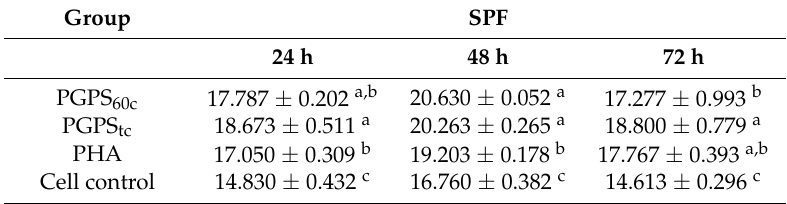
Figure 3. Changes of cell cycle distribution in synergistically stimulation of PGPSs with PHA. The values are presented as means ± SE ( n = 4). Table 4. SPF value of peripheral lymphocyte cell cycle of each group at different time points ( n = 4).